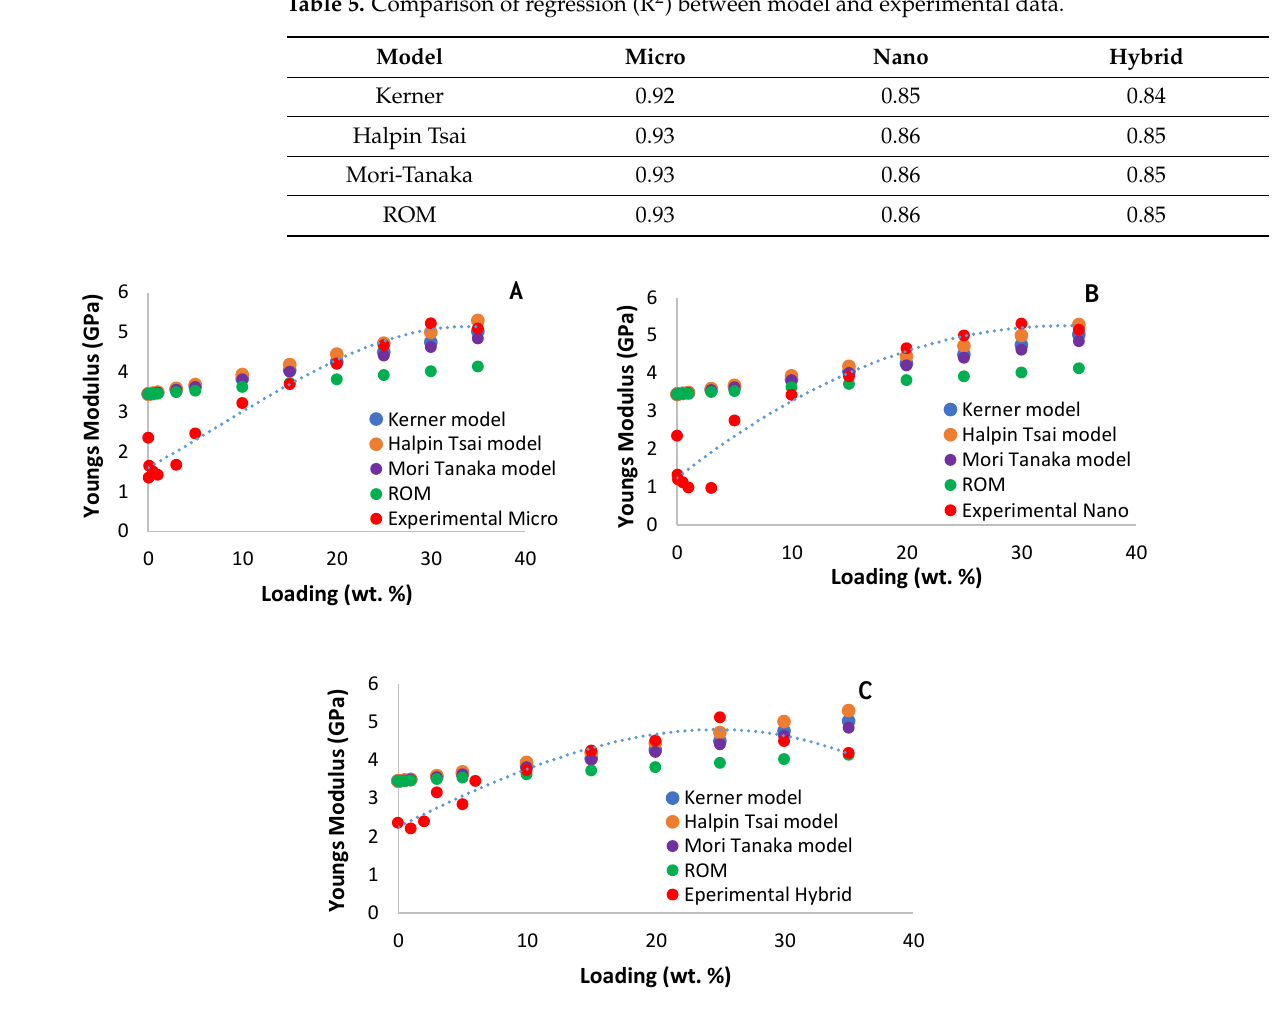
Figure 5. Comparison between the theoretical models and experimental data of epoxy silica filler with different sizes and combinations of fillers as a function of loading wt.%. Where ( A ), is the comparison for Micro silica, ( B ), is the comparison for Nano and ( C ), is the comparison for Hybrid